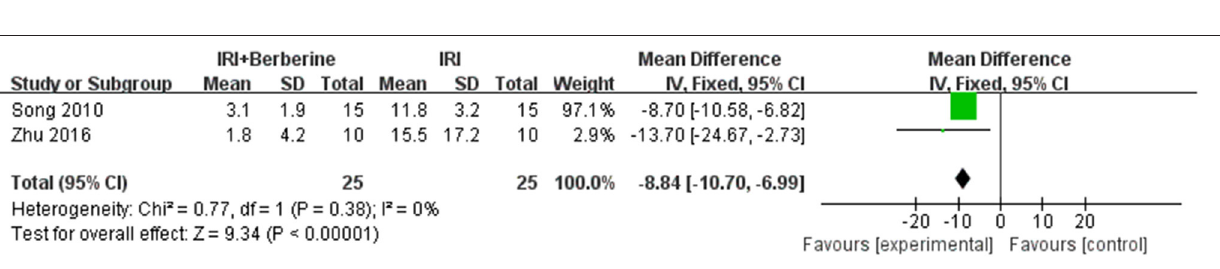
FIGURE 9 | Forest plot showing effects of BBR on decreasing the cumulative duration of ventricular fibrillation in the control group.